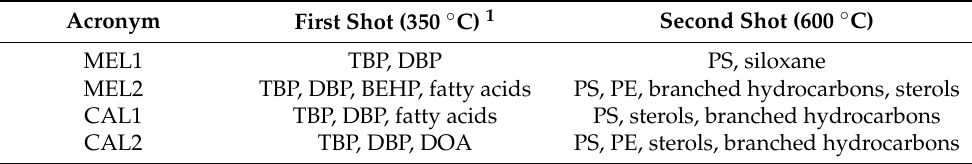
Table 5. Most abundant species identified by double shot-Py-GC/MS in the DCM